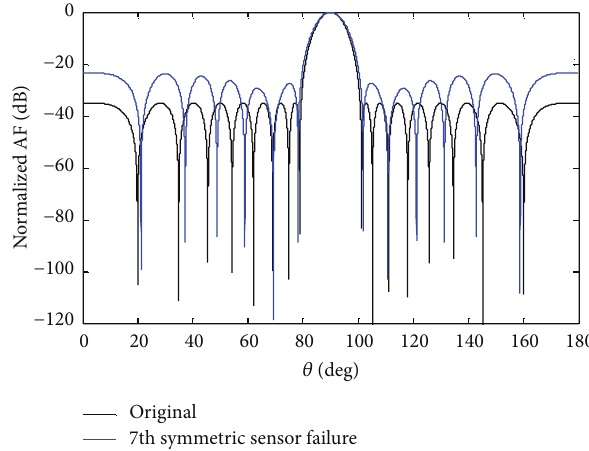
Figure 2: The original Chebyshev array and the 𝑤 7 symmetric sensor failure.